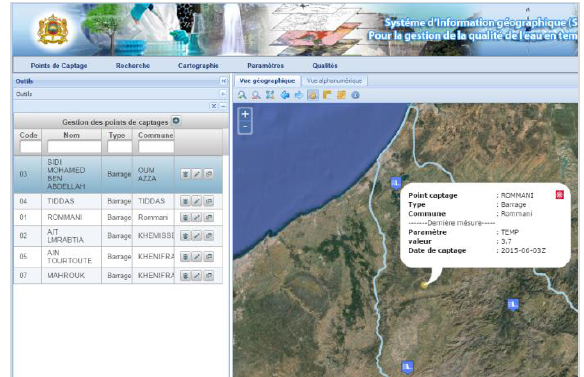
Figure 5. Main interface of the GIS application The data is collected by the sensors, distributed in catchment unities, transferred at scheduled intervals to the server and then the real-time water quality map of the study area is displayed using the GIS application.